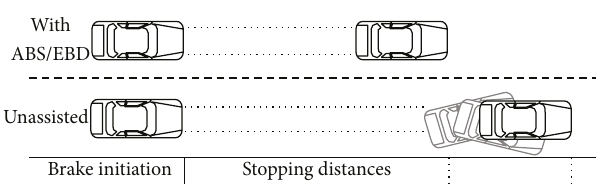
Figure 6: Differentiation of stopping distances for vehicle equipped with ABS/EBD and unassisted vehicle.